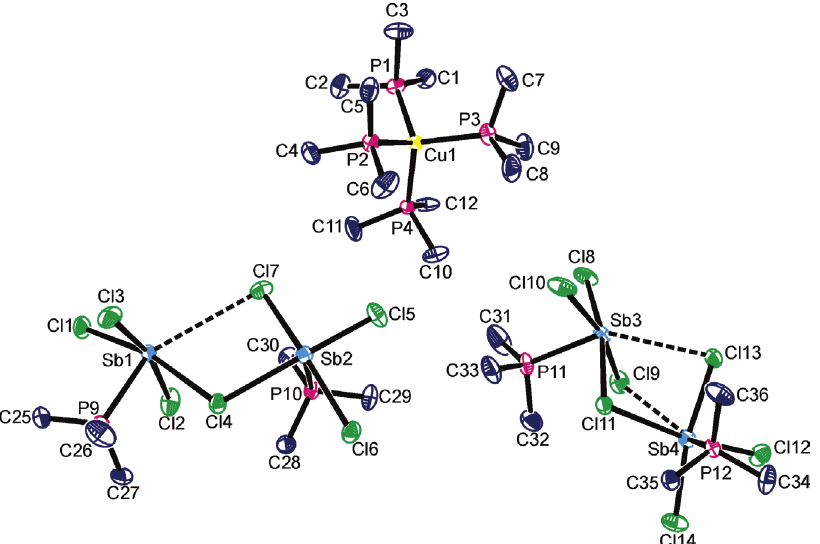
P) Cu] + cations in the asymmetric unit of 8 showing the labeling scheme used. Figure 9 One of two [(Me 3 4 Thermal ellipsoids are at the 40% probability level. Hydrogen atoms have been omitted for clarity. For selected geometric data, see Table